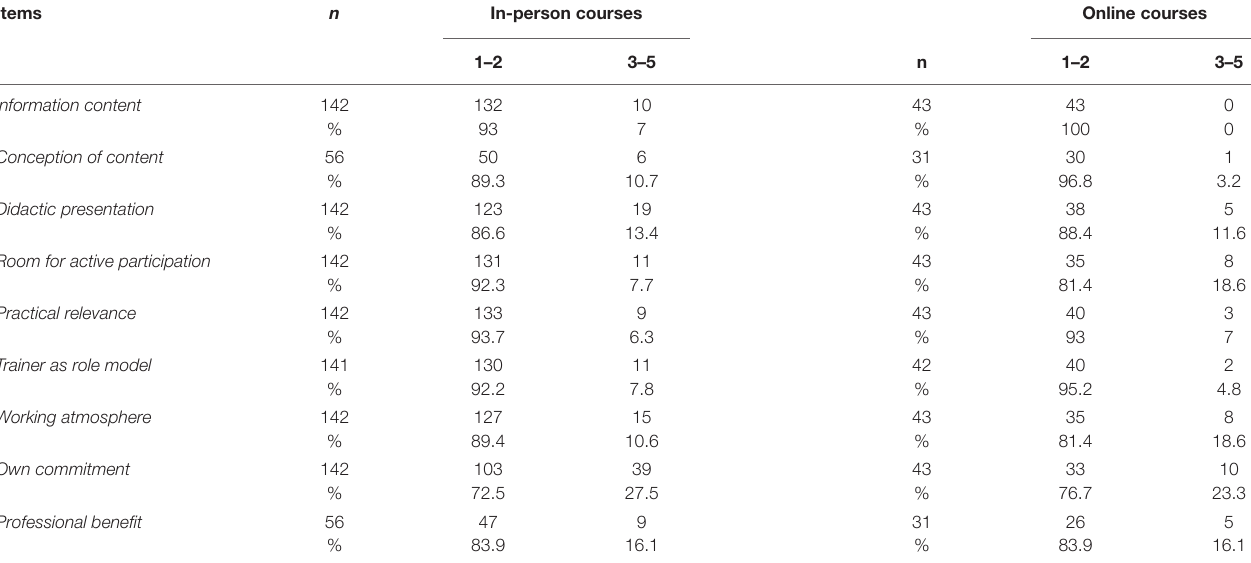
FIGURE 2 | Relative frequencies of items of the Satisfaction and acceptance questionnaire for online and in-person courses. 1 = “very satisfied,” 5 = “not at all satisfied.” TABLE 2 | Descriptive data and percentage of positive vs. neutral/negative ratings in online courses vs. in-person